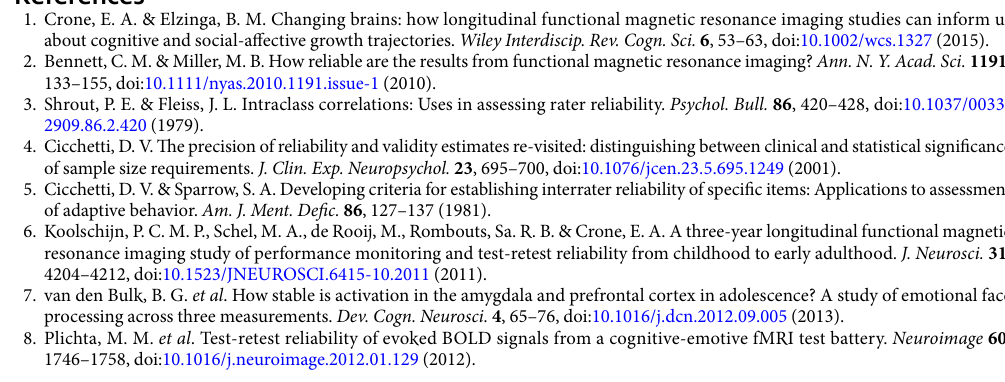
Intertemporal choice paradigm. For this paradigm, ROIs of the fusiform gyrus, the superior parietal lobe as well as the ACC were created by using the overlap of functional activation of the intertemporal decision phase 22, 56 and anatomical regions using the WFU-PickAtlas with the AAL atlas. The overlap with anatomical regions was necessary to create distinct ROIs because the activation spanned one very large cluster across the whole brain. We additionally chose the VS as a ROI since it is highly relevant for reward paradigms. The anatomical ROIs of the VS were created with the WFU-PickAtlas using the AAL atlas. Analyses of reliability. specific conditions and overall reaction times across conditions and for the intertemporal choice paradigm, log-transformed discount parameters were analyzed for reliability. FMRI reliability. FMRI ICCs were calculated with the ICC toolbox of Caceres et al . 60 . We used the intra-voxel reliability “ ICC v ” obtained by using the contrast value of each voxel within each ROI of each individual subject. The population estimate was obtained by bootstrapping with 1,000 re-samples of participants, of which medians and standard errors are reported. Additionally, whole brain ICCs were calculated, since this is the strictest crite- rion and potentially the most valuable reliability measure as it yields a global measurement of test-retest agree- ment 2 . ICCs were classified according to Cicchetti 4 as poor, < 0.40, fair, 0.41–0.60, good, 0.61–0.75, and excellent, > 0.75 (see also ref. 5).